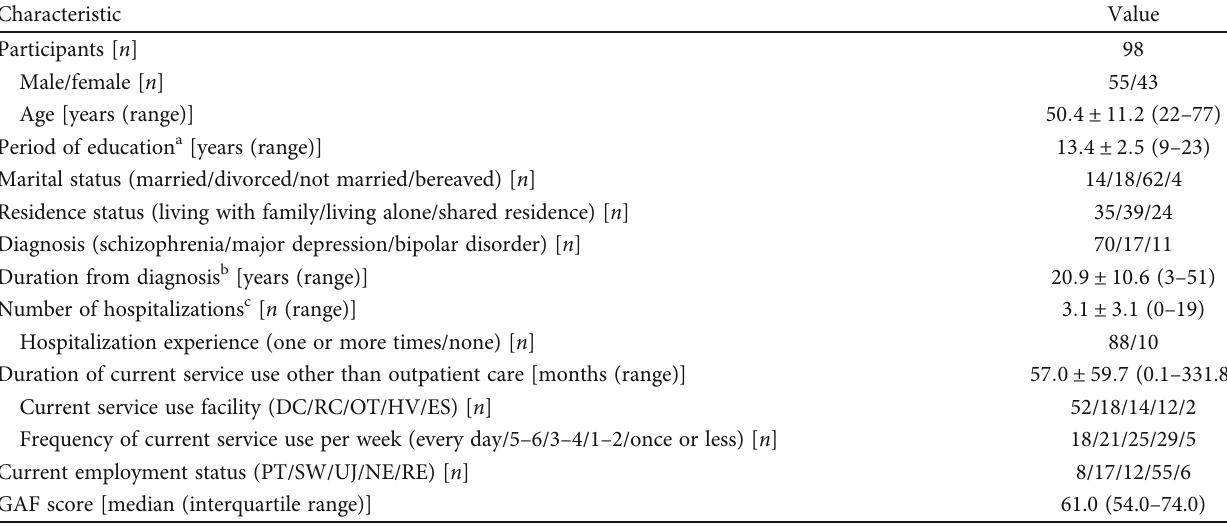
Table 1: Characteristics of the participants.